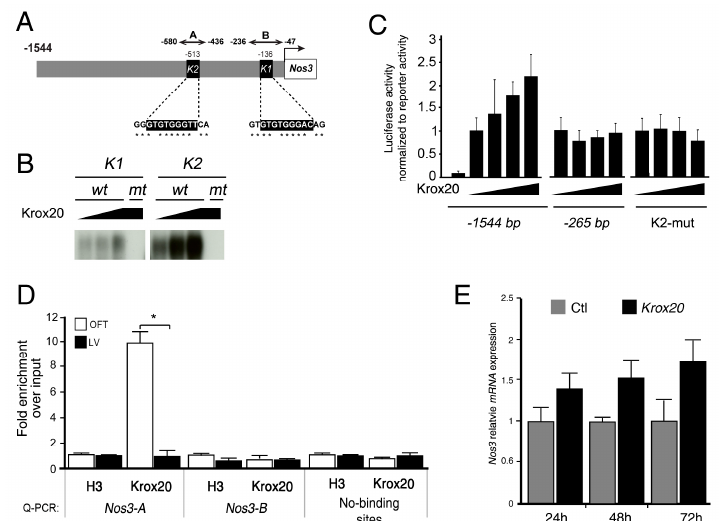
Figure 4. Krox20 promotes the transcriptional activity of the Nos3 proximal promoter. ( A ) Schematic representation of the 1.5-kb Nos3 proximal promoters. The putative Krox20 binding sites located around − 513 bp and − 136 bp on Nos3 promoters are represented by black squares. Asterisk (*) indicates conservation of Krox20-binding sites with human and rat sequences. Numbers indicate position of the sequences from the ATG. ( B ) EMSA showing binding of Krox20 to the wild-type K1 (GTGTGGGAC) and K2 (GTGTGGGTT) motifs. Mutation of the K1 and K2 motif impairs Krox20 binding. ( C ) Relative luciferase activity in Cos7 cells transiently co-transfected with reporter constructs containing a 1544 bp and 265 bp regions of Nos3 promoter cloned upstream of the luciferase gene, 10 ng of control pGL4.74( hRluc / TK) vector and 50, 150, and 300 ng of CMV-Krox20 or CMV control expressing vectors. Transfection of CMV- Krox20 has a trans-activating e ff ect on − 1544 bp reporter. Mutation of the K2 motif abolishes the trans-activation of Krox20 on the − 1544 bp reporter. Data is represented as a fold change in luciferase activity normalized to Renilla . ( D ) qPCR showing significant enrichment of DNA / Krox20 complexes on Krox20-binding sites within the Nos3 (regions A) proximal promoters following chromatin immunoprecipitation using dissected outflow tract (OFT) and left ventricle (LV) from E13.5 hearts. Anti-Histone H3 was used as positive control of immunoprecipitation. Primers used for qPCR correspond to Nos3 proximal promoter region ( Nos3-A , Nos3-B ) as indicated in ( A ). Primers in region without Krox20 binding sites (no binding site) were used as a negative control. Relative quantities of each chromatin bound fragment were normalized relative to the amount of input DNA. Note significant enrichment in region A within the Nos3 promoters. ( E ) Nos3 transcriptional level was quantified by qRT-PCR in rat AVICs, 24 h, 48 h, and 72 h after Krox20 transfection. Experiments were performed in triplicate and expressed as means ±